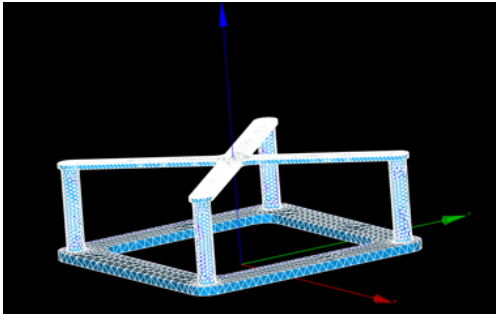
Figure 9. Nautilus stl file obtained from